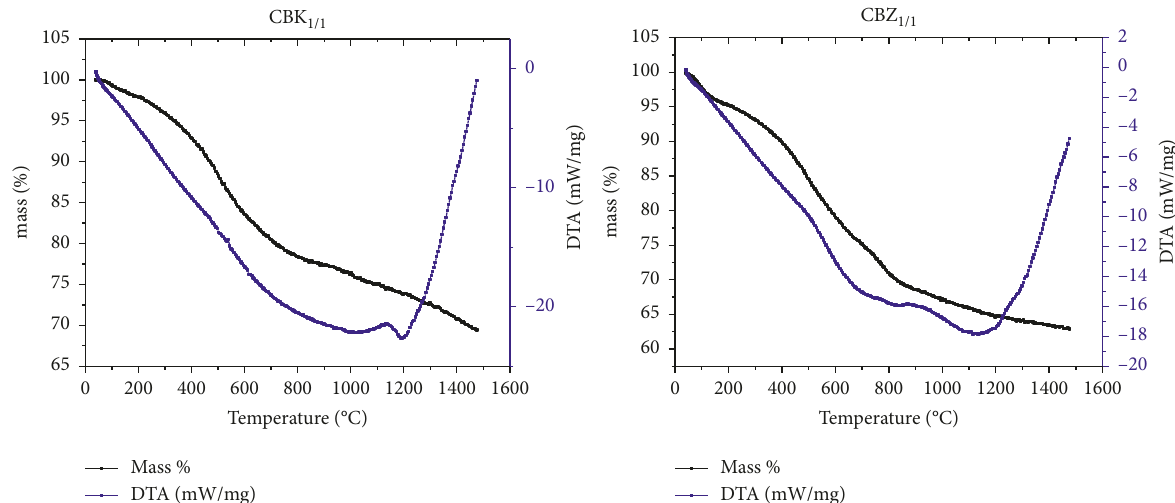
Figure 5: Thermogravimetric analysis (TGA) and differential thermogravimetric curves (DTA) of CBK